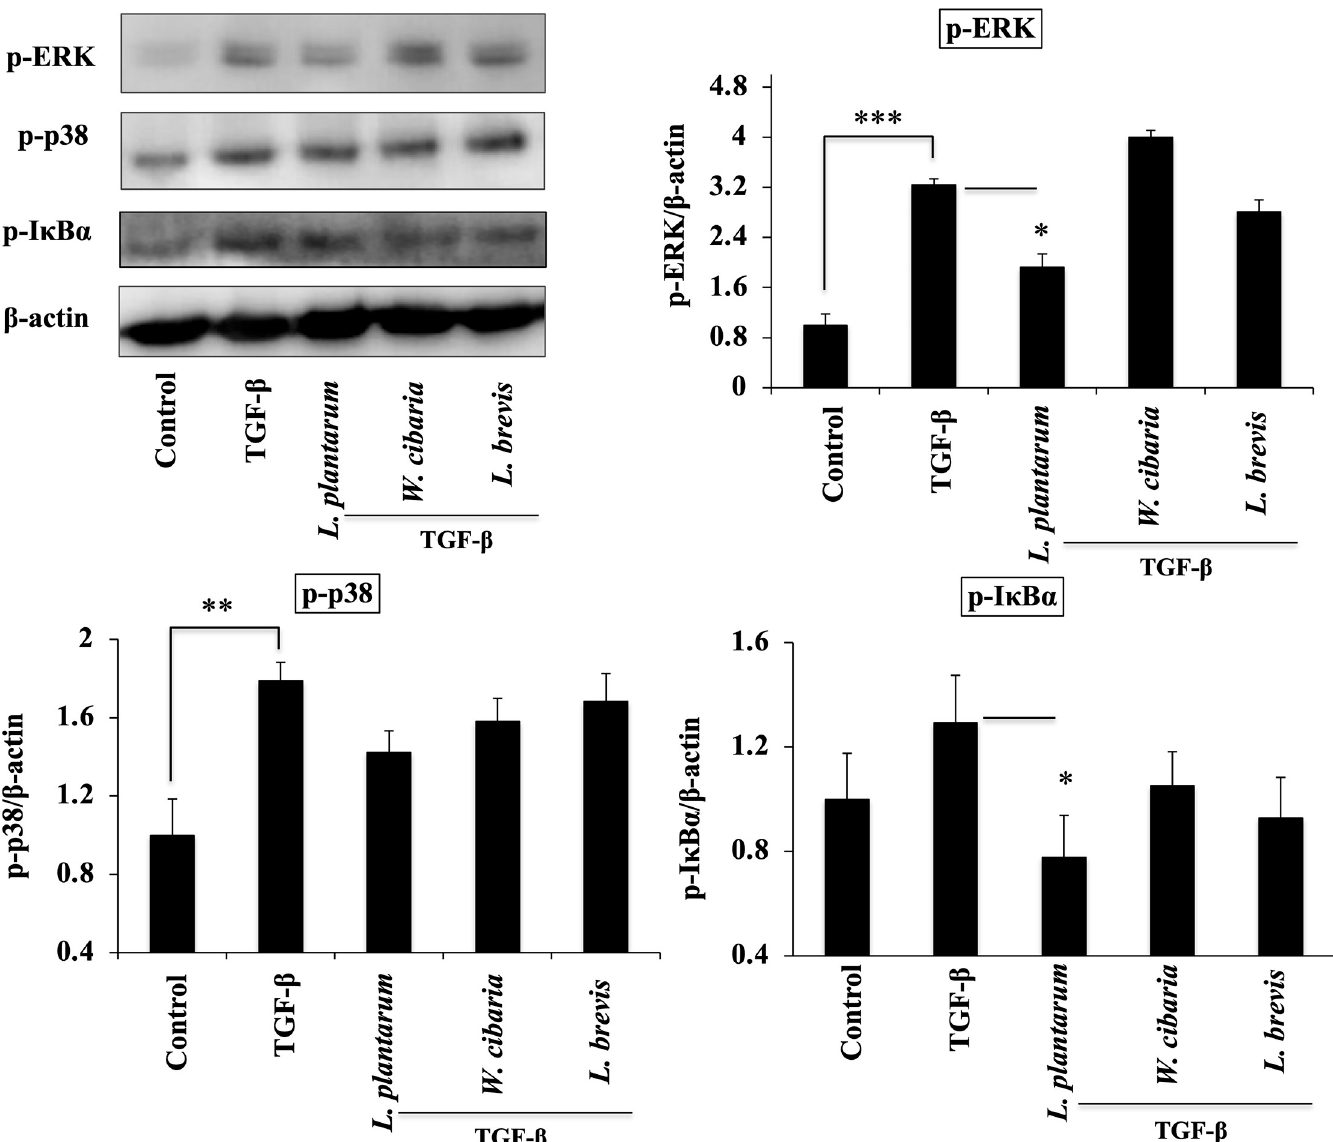
Fig 6. LAB strains modulate SMAD-independent TGF- β signaling in LX-2 cells. Confluence LX-2 cells were treated with LABs for 48 h, and stimulated with TGF- β for 120 minutes. Western blot was performed to determine the phosphorylation of ERK, p38, and I κ B α at the indicated time point. The Image J software was used to determine the intensities of protein bands. The bar graphs are the average of two different experiments (mean + S.D). � p < 0.05, �� p < 0.01, ��� p <